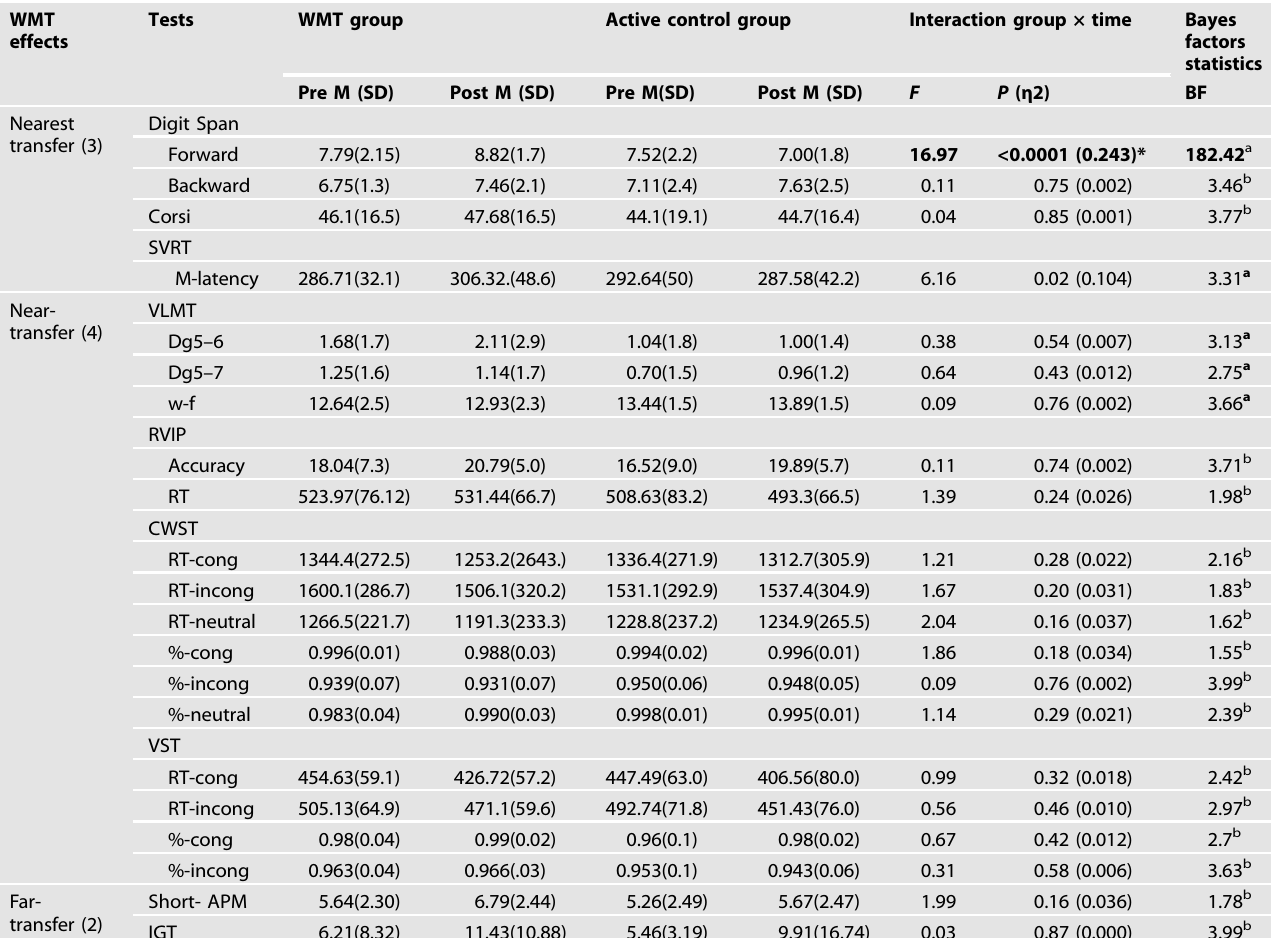
Table 2. Univariate ANOVA for all transfer